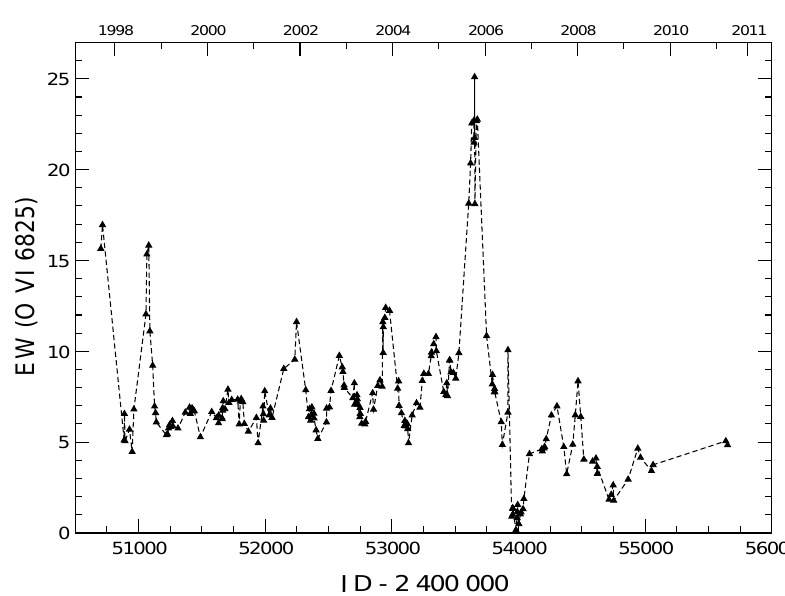
Fig. 5. EWs of the O VI (cid:21) 6825 line in the spectrum of AG Dra in